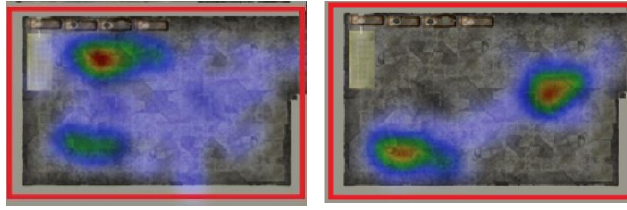
Figure 3. G-player heat maps